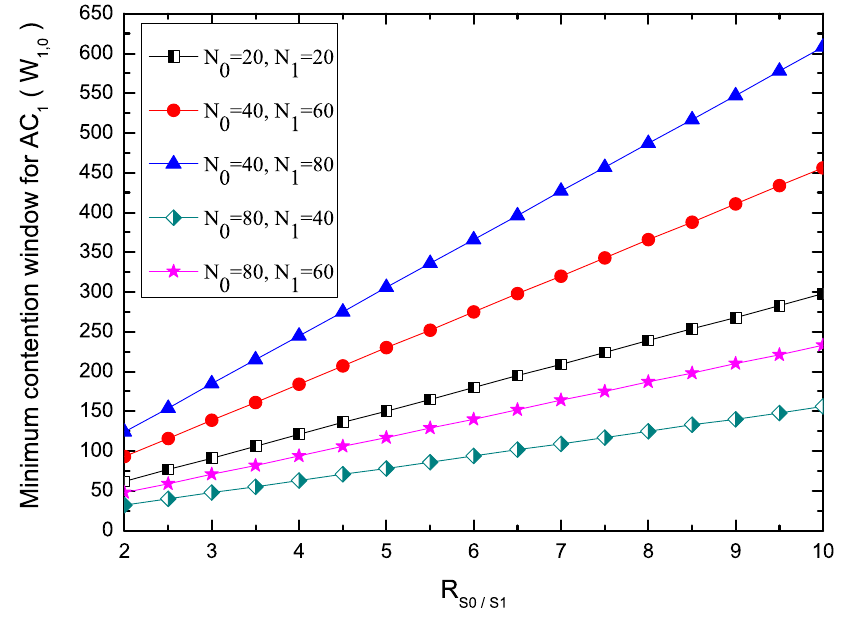
Figure 4. Minimum contention window for AC 1